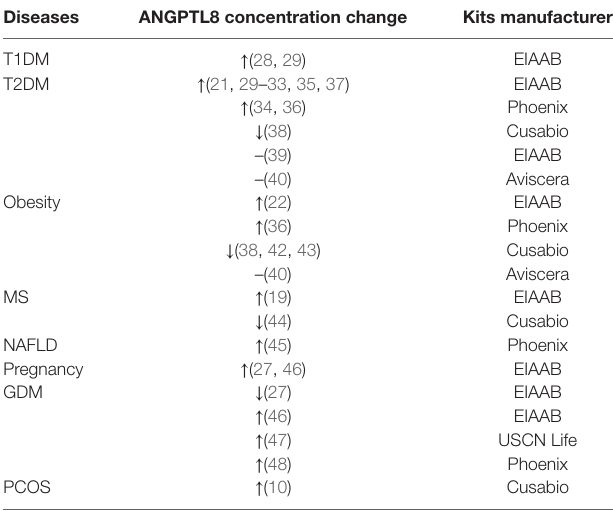
TAbLe 2 | ANGPTL8 concentration in